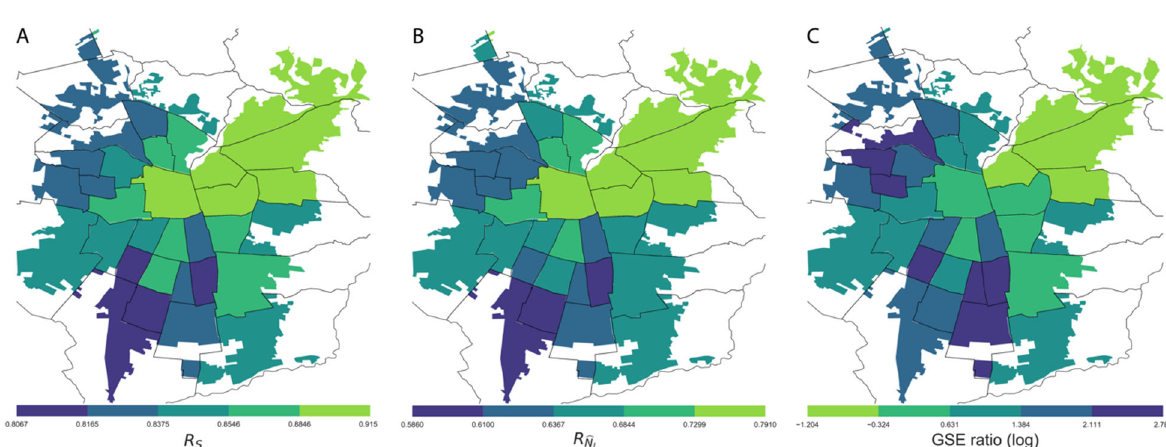
Fig. 2 Spatial patterns of gender mobility inequalities and wealth. Choropleth maps of the metropolitan area of Santiago showing the women to men ratio of entropy ( a ) and of the number of locations accounting for 80% of users ’ activity ( b ) by comuna . Panel c shows the spatial distribution of the GSE ratio. Black lines indicate the administrative boundaries of the comunas . The boundary of the colored area corresponds to the urban area of Santiago as de fi ned by the National Institute of Statistics (INE).